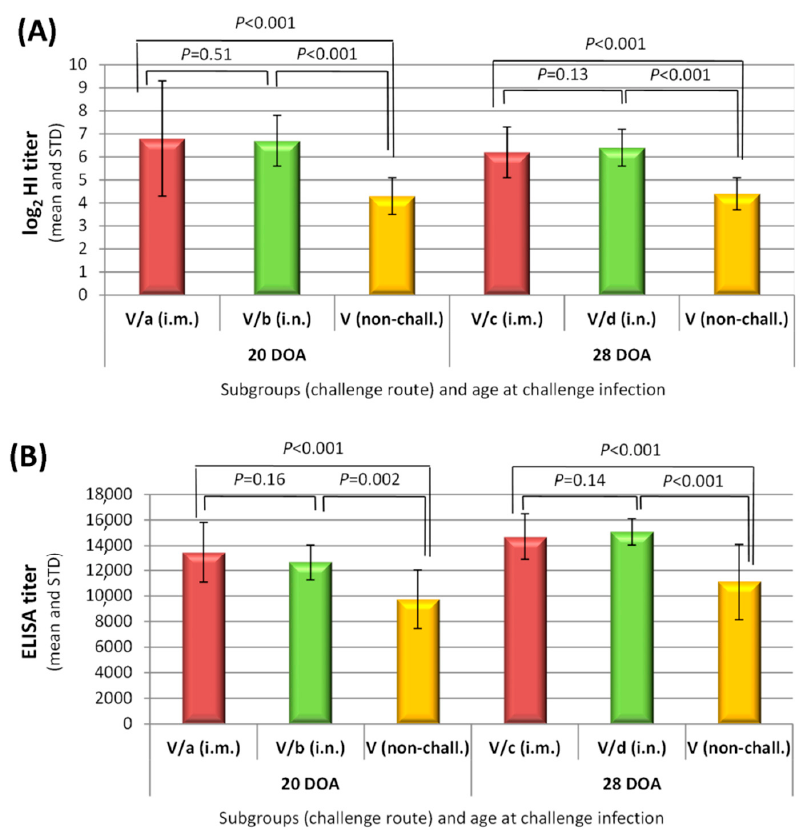
Figure 2. Booster effect of the challenge infection on the humoral immune response to vaccination as measured 14 days post-challenge. Hemagglutination Inhibition test ( A ) and IDScreen ® ND indirect ELISA ( B ) results. Day-old SPF chickens were vaccinated subcutaneously and separate subgroups were submitted to velogenic NDV challenge, either by intra-muscular or intra-nasal route at 20 or 28 days of age. Mann – Whitney test was used for the comparison of post-challenge serological results with the corresponding non-challenged vaccinated group at the same age (“effect of challenge”) and for the comparison of corresponding intra-muscularly and intra-nasally challenged groups at the same age (“effect of challenge route”). Results are shown above the columns. DOA: days of age. Table 5. Humoral immune response of vaccinated chickens to challenge—Nucleoprotein ELISA